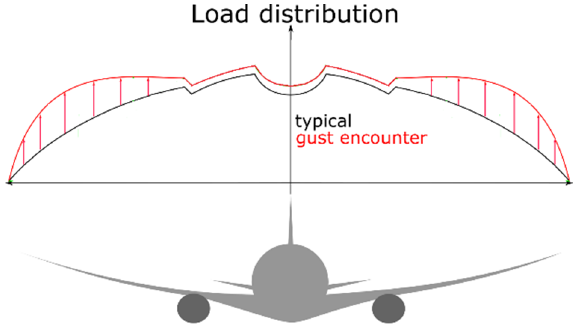
Figure 2. The sketch of the spanwise load distributions under cruise and gust encountering conditions (from [30]).